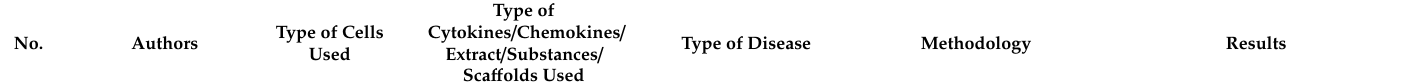
Table 1. Summary of the 4 articles conducted in vitro that were selected from both Pubmed and Scopus